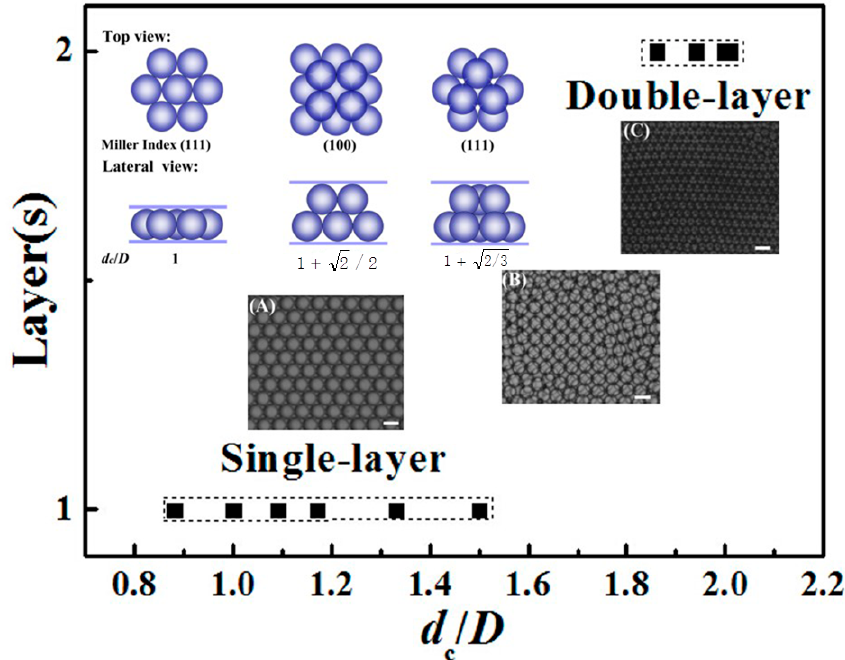
Figure 7. Diagram of droplets close-packing configurations corresponding to d c / D . The top-left insertion is the schematic drawing of droplets pattern in Miller lattice orientations. The images of (A), (B) and (C) were single-layer hexagonal (111), double-layer square (100) and double-layer hexagonal (111) configurations, respectively. Scale bars are 50 µ m. Here, the microfluidic device was: w = 25 or 50 µ m, d = 40 µ m, W = 400 µ m. f c a Hexadecane with 2.7% ( w/v ) Span80 and DI water were used as the oil phase and water phase, d c = 40 μ m and W a = 400 μ m. d c / D value was dynamically controlled by adjusting droplet size for a given